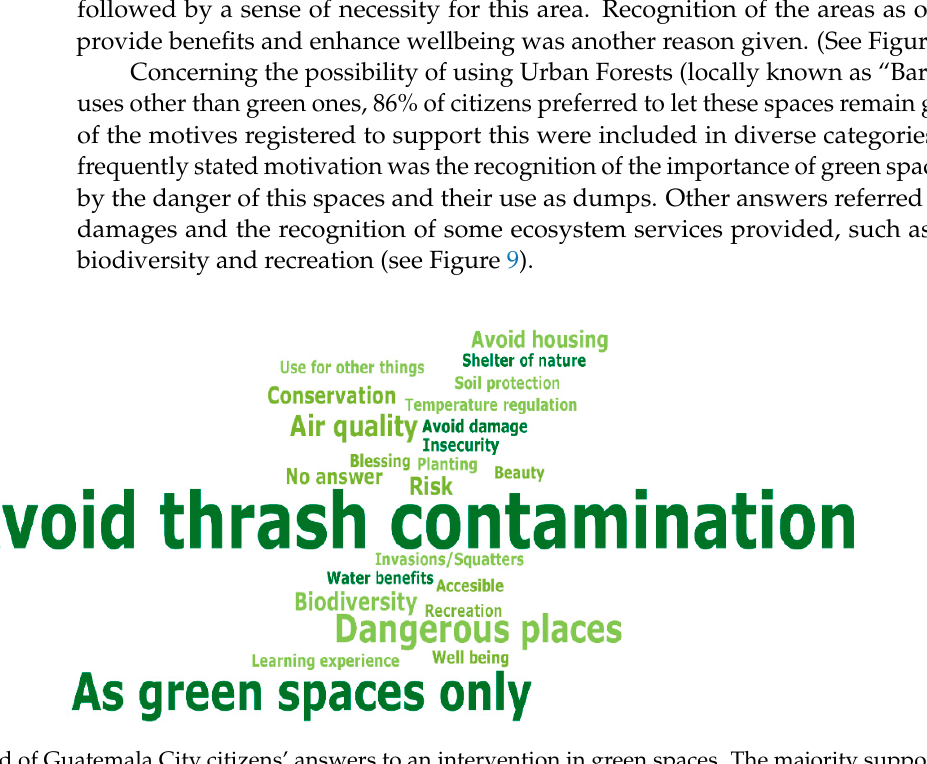
Figure 9. Code cloud of Guatemala City citizens’ answers to an intervention in green spaces. The majority support using urban forests (ravines) only as green spaces. All the reasons come from responses that agreed with this use.